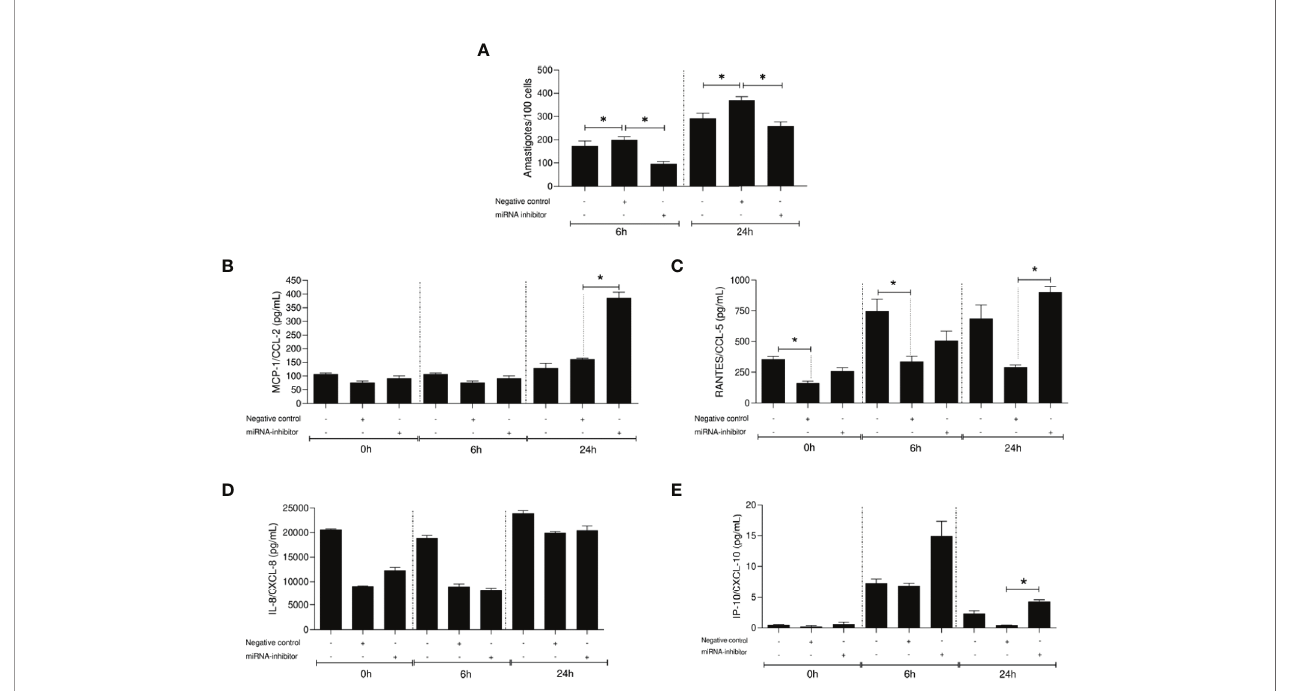
FIGURE 6 | Parasite load (number of amastigotes/100 cells) (A) and chemokine levels (pg/ml) (B – E) in L. (V.) braziliensis promastigote-infected THP-1 cells transiently transfected with miR-548d-3p inhibitor at 6 and 24 h post-infection. One experiment was carried out by adding the miR-548d-3p inhibitor (10 nM) or negative control (scrambled miRNA; 10 nM) with the transfection reagent diluted in RPMI medium or only RPMI medium (non-transfected cells) to wells containing 10 6 THP-1 adherent cells and maintained for 24 h at 37°C (5% CO2) then infected with L. (V.) braziliensis promastigotes. (A) * = P < 0.05 (one way ANOVA and Student t test). MCP1/CCL2 (B) , RANTES/CXCL5 (C) , IL-8/CXCL8 (D) , and IP-10/CXCL10 (E) concentrations were measured by fl ow-cytometry using the CBA kit. (B – E) * = p <0.05 (Kruskal-Wallis and Bonferroni